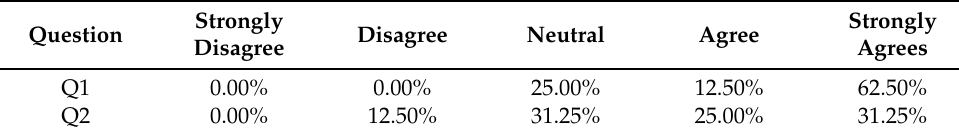
Figure 17. User Interface of the XR Periscope. Table 3. Q1,Q2—User